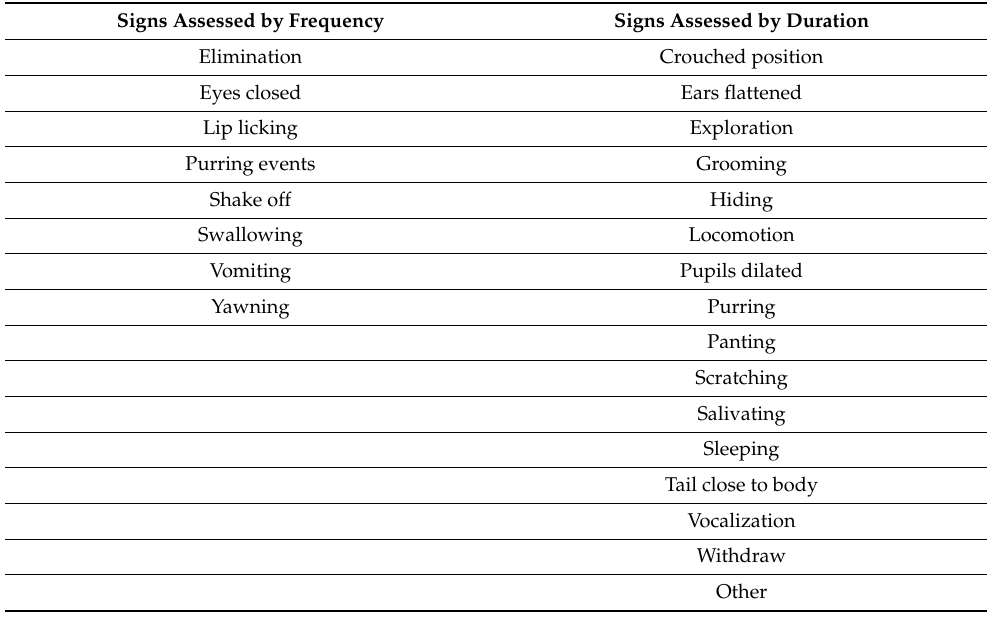
Table 5. The signs assessed by the external observer in video assessment of cats. Modified from Lamminen et al. (2021) [14].